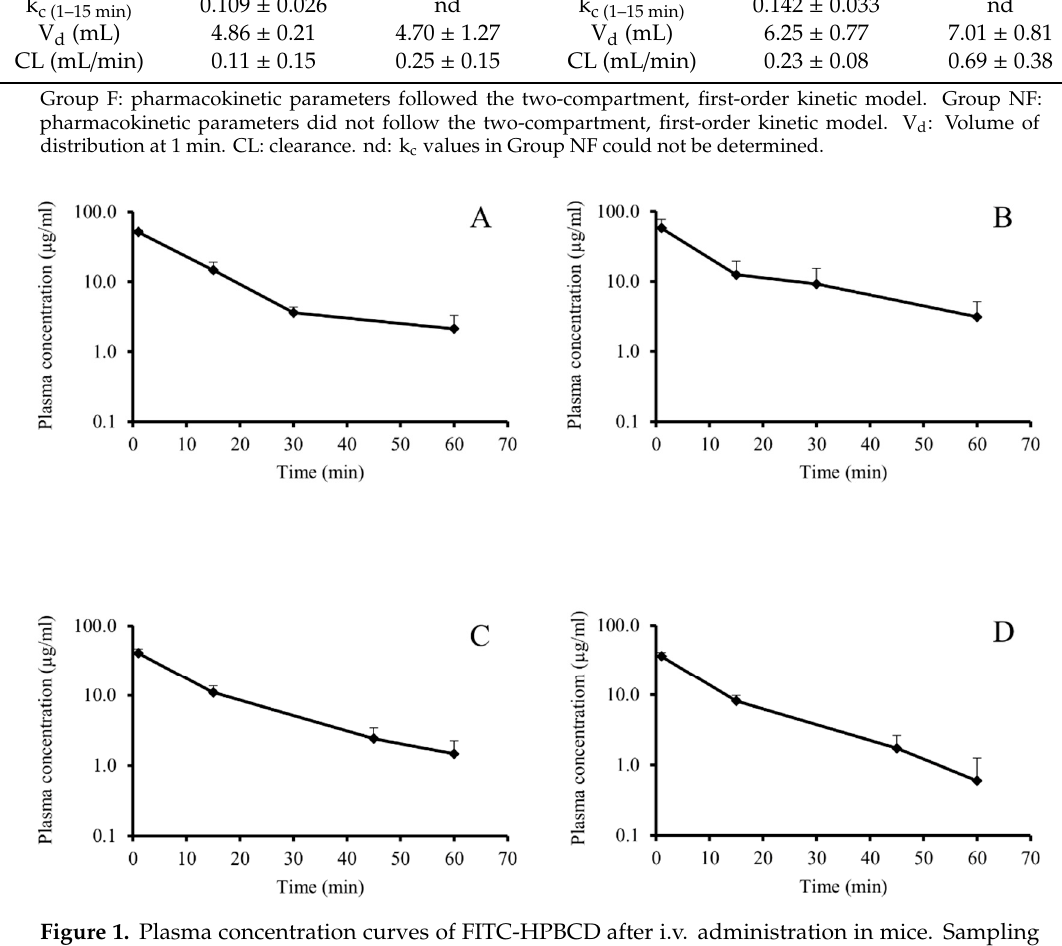
Figure 1. Plasma concentration curves of FITC-HPBCD after i.v. administration in mice. Sampling times 1, 15, 30 and 60 min ( A and B ; n = 6) and 1, 15, 45 and 60 min ( C and D ; n = 6). A and C followed the first-order elimination kinetic, while B and D did not follow it.